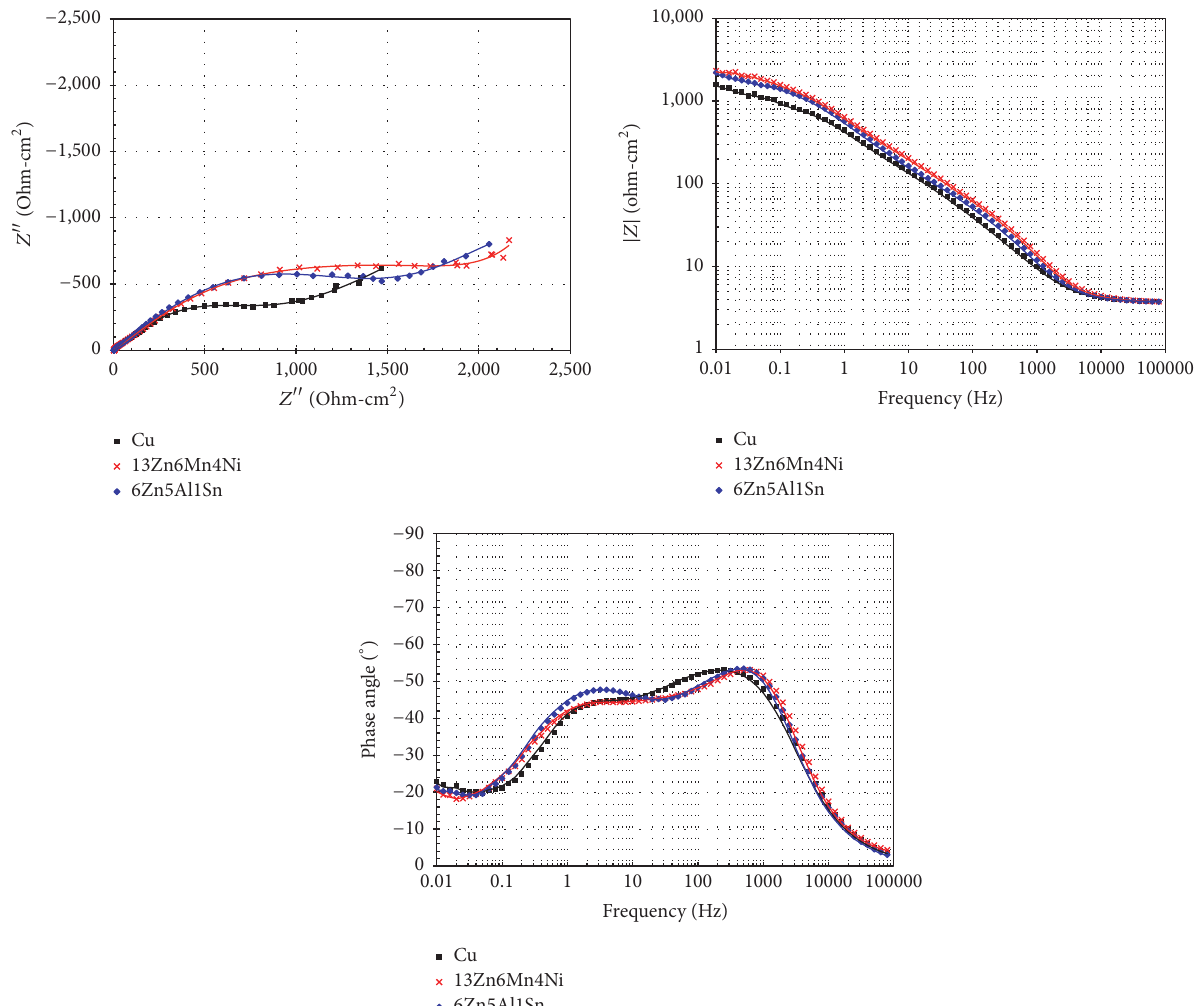
Figure 7: Nyquist and Bode plots for the Cu-based quaternary alloys in artificial sweat at 37 ∘ C after 24 hours. Points are the experimental data, and the continuous lines are the fitting data.